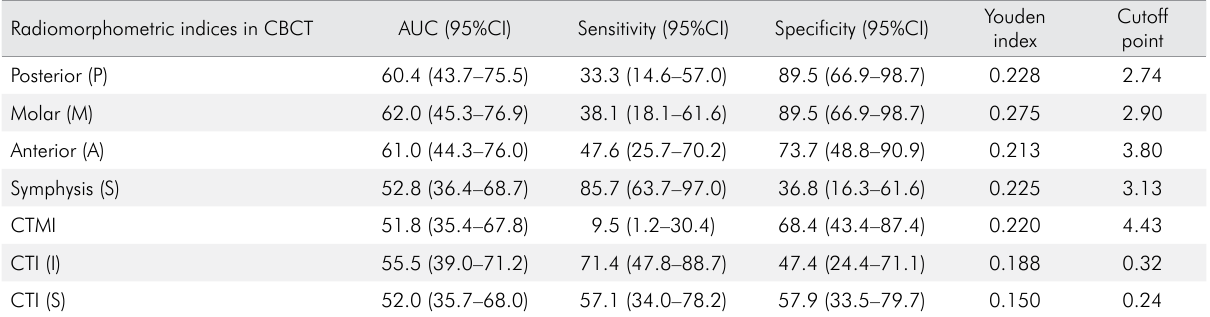
Table 2. Evaluation of area under the curve (AUC), sensitivity, specificity, Youden index, and cutoff point of the radiomorphometric indices in cone beam computed tomography